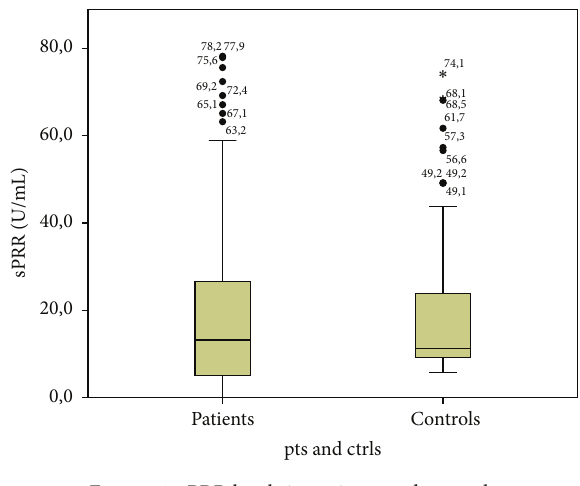
Figure 1: sPRR levels in patients and controls. Table 2: Mean and median of serum levels and 𝑝 value of sPRR.